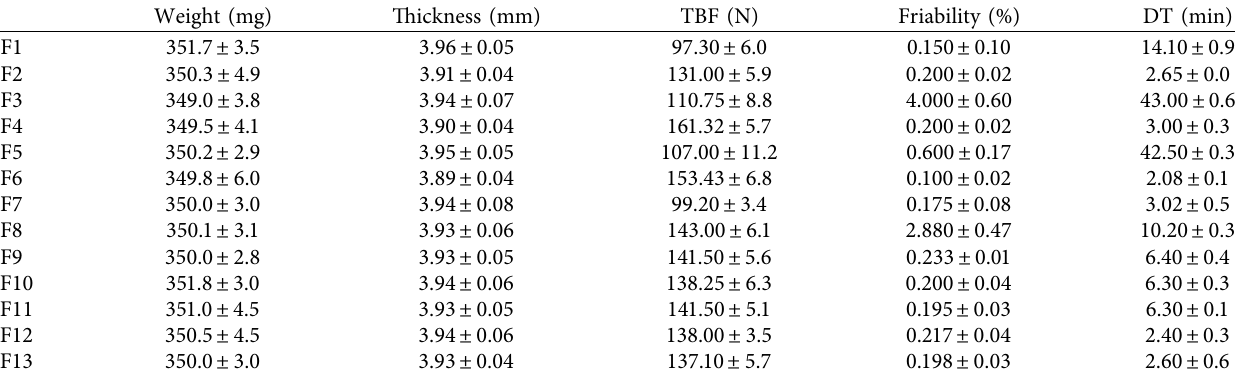
Table 3: Weight, thickness, TBF, friability, and DT values of paracetamol tablets prepared with NTBIS as